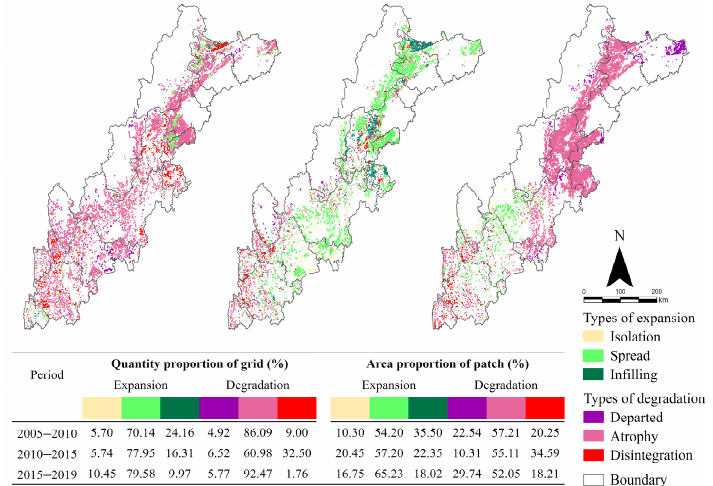
Figure 7. Spatial-temporal distribution of specific types and its quantity and area proportions.